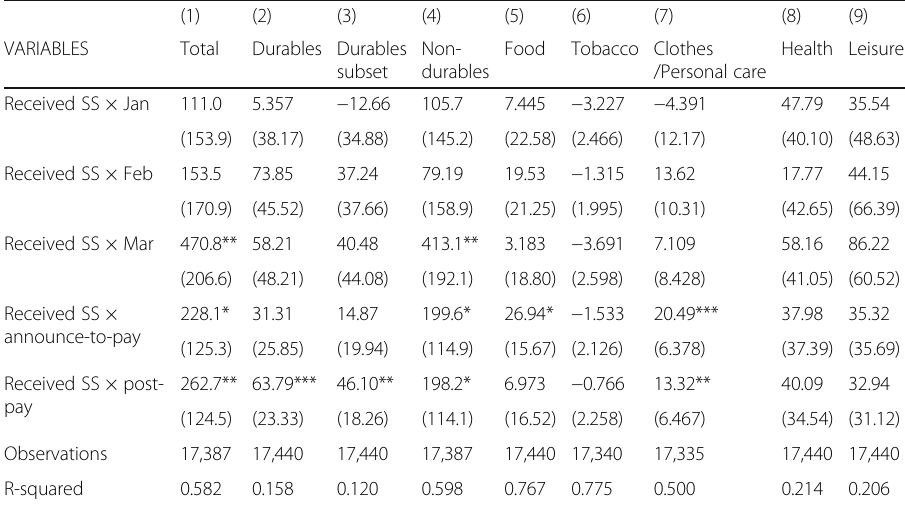
Table 25 Robustness check for expenditure — using non-age-eligible sample as a control group (propensity score 0.2 –